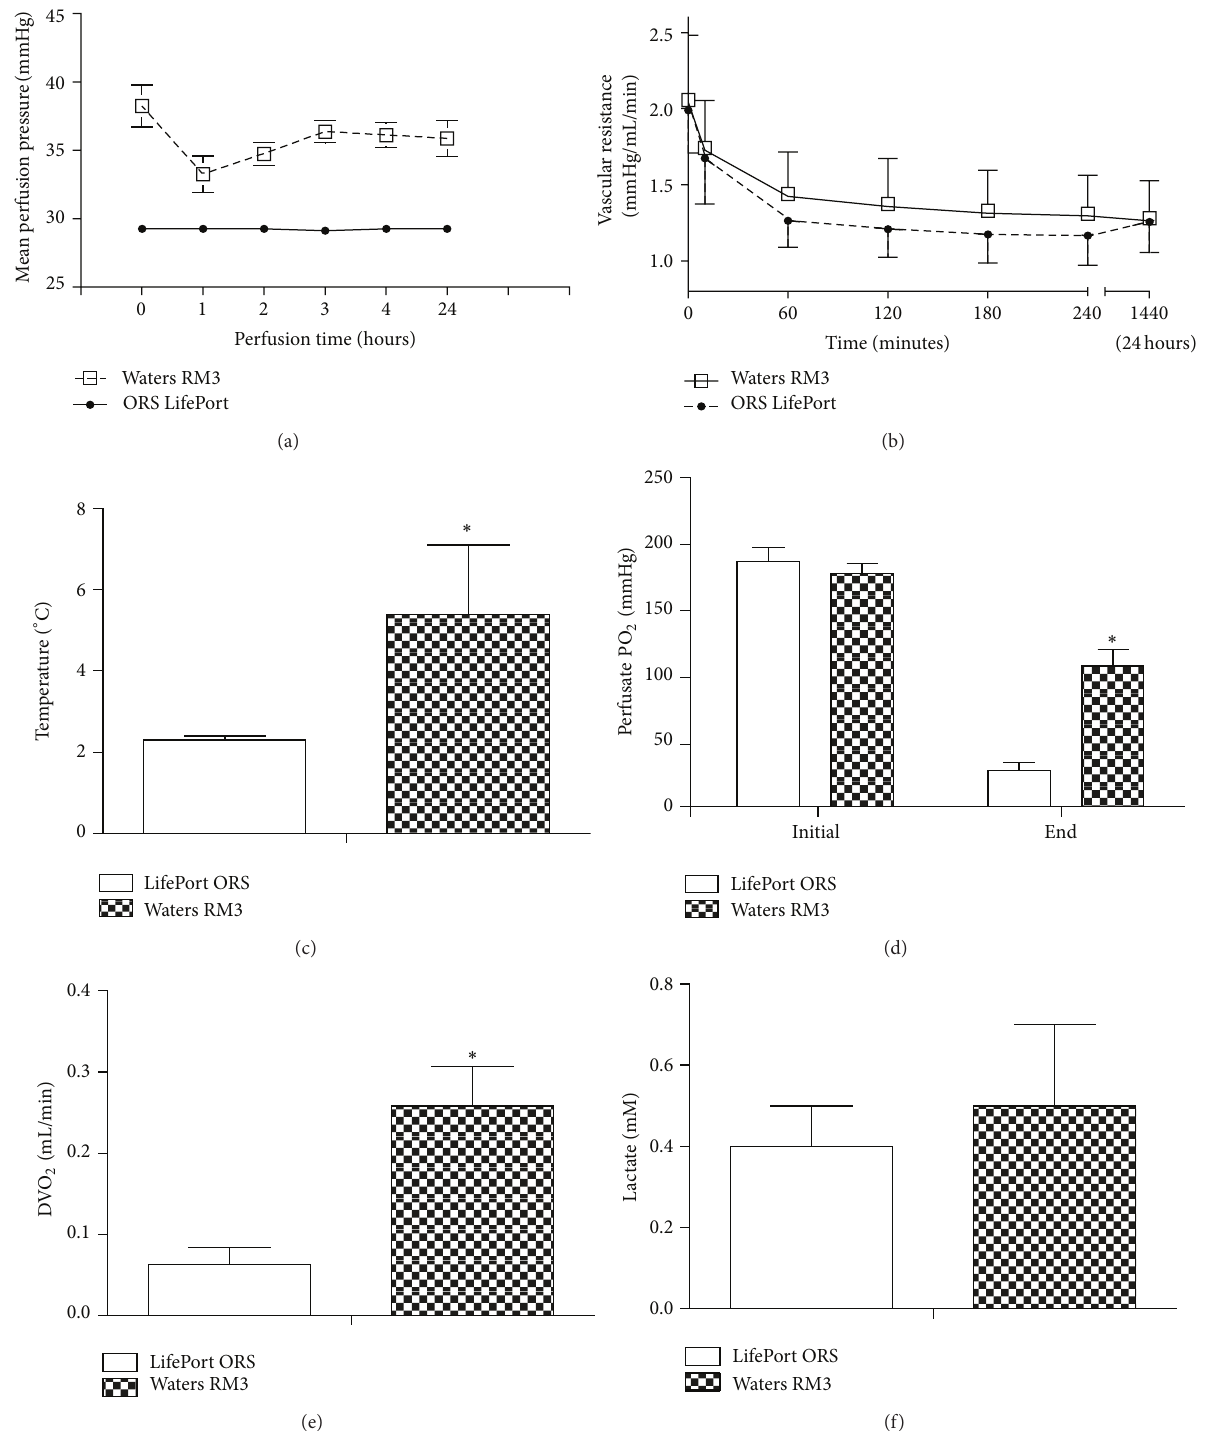
Figure 1: Machine perfusion characteristics of DCD kidneys pumped on a Waters RM3 or an ORS LifePort device for 24 hours. Mean perfusion pressure (a), vascular resistance during perfusion (b), average perfusate temperature (c), initial and end perfusate pO 2 values (d), end of perfusion delivery of oxygen (DVO 2 ) (e), and end of perfusion perfusate lactate concentrations (f) values are mean ± S.D., ∗ 𝑃 < 0.05 relative to LifePort, 𝑛 = 8 per